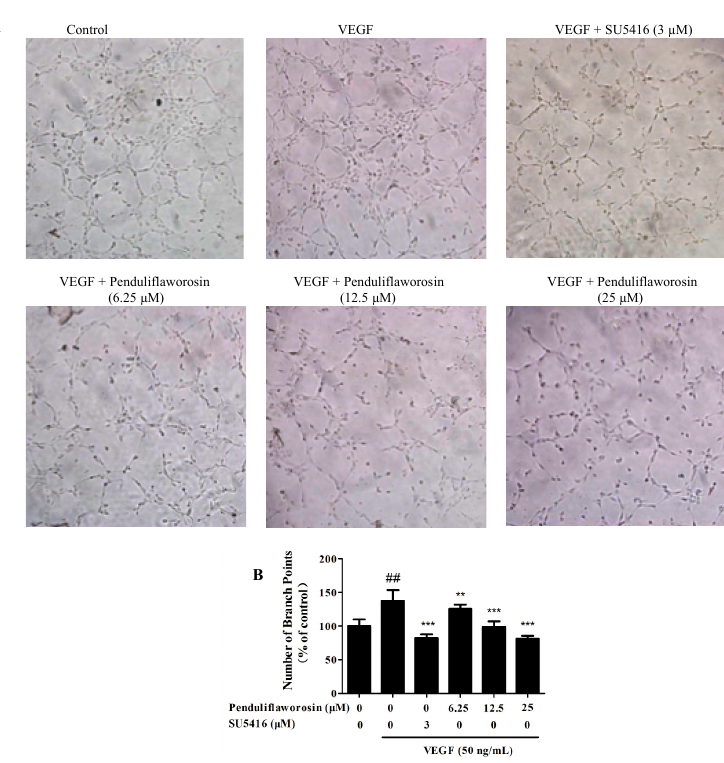
Figure 3. Penduliflaworosin suppressed VEGF-induced tube formation of HUVECs in a dose-dependent manner. ( A ) The tube formation of HUVECs was photographed. The numbers of ( B ) branch points in the tubes were counted after treatment with different concentrations of compounds (penduliflaworosin or SU5416). Cells with medium only were used as the vehicle control, and data are presented as the percentage of the control. Values are represented as the mean ± standard deviation ( n = 3). Mean values showing significant differences between the control group and the VEGF-treated group are denoted by ## ( p < 0.001). Mean values showing significant difference between the VEGF-treated group and penduliflaworosin-treated group are indicated by ** ( p < 0.01) or *** ( p < 0.001).